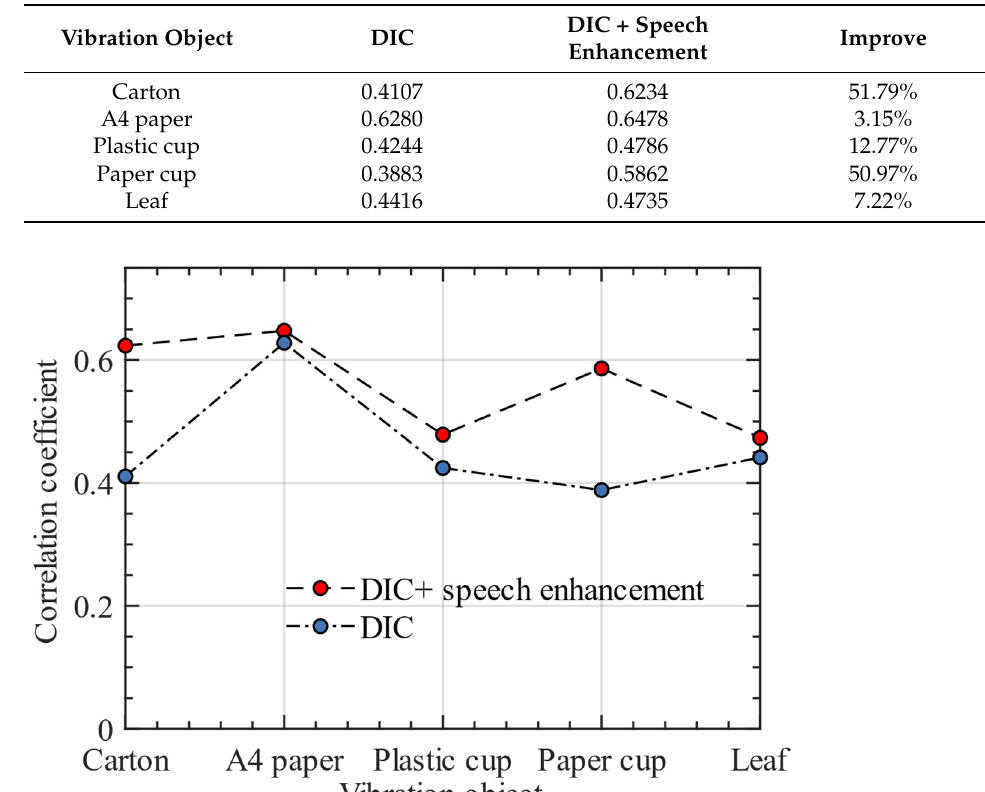
Figure 16. Accuracy comparison of speech signal reconstruction with and without enhancement .